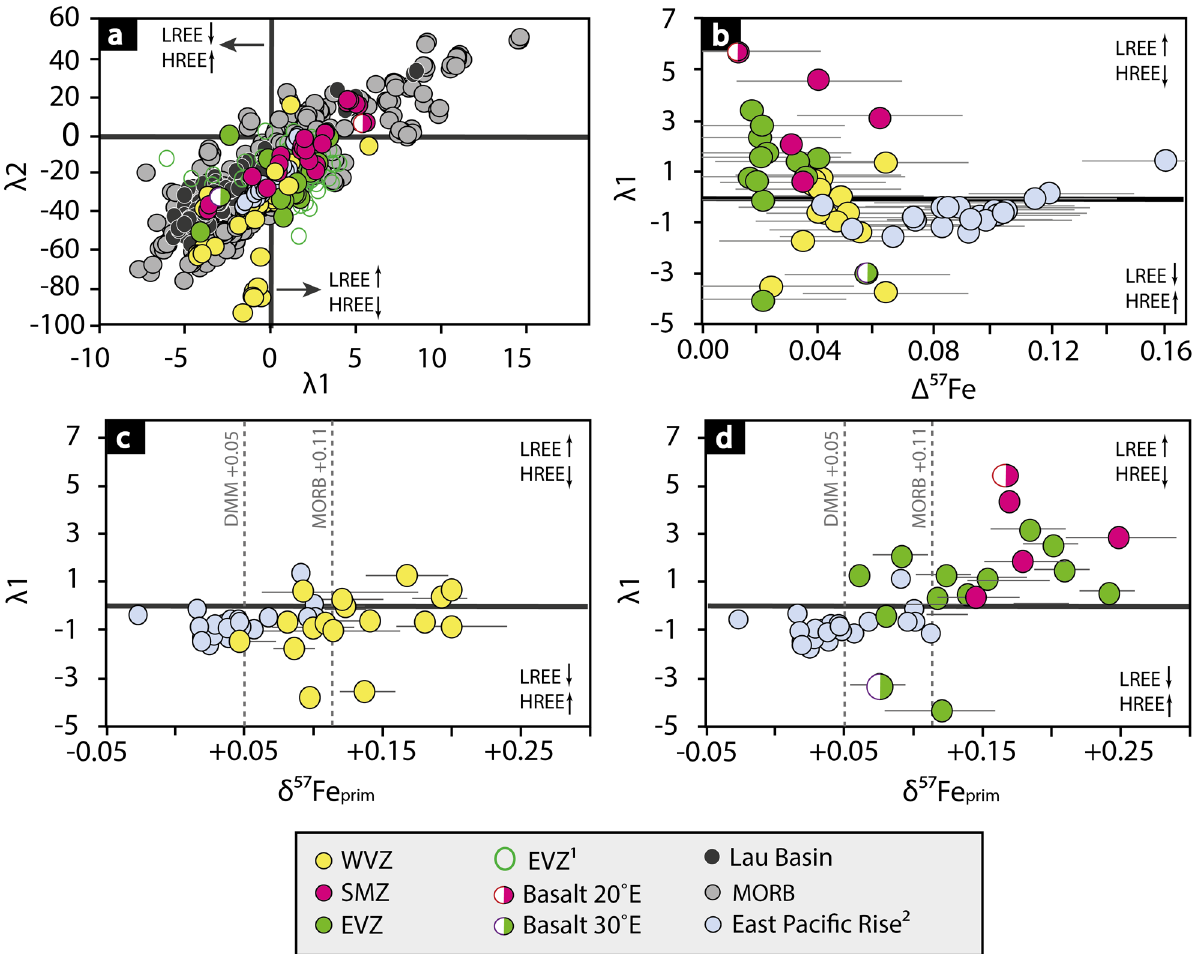
Figure 3. Rare Earth Element (REE) patterns versus δ 57 Fe prim . The REE patterns are given here as λ1 and λ2, describing the slope (λ1) and curvature (λ2) of the REE pattern. These parameter provide further information about the mantle source and petrogenesis 58 , which we link with iron isotope systematics. Lambda variables were calculated using the method of O’Neill 58 . λ1 (slope) can be translated to: λ1 > 0 indicates an enrichment of LREE over HREE, and λ1 < 0 represents the opposite with an enrichment of HREE over LREE. λ2 (curvature) marks the relative difference in LREE over HREE which captures the influence of mineralogy as a function of respective partitioning during fractionation or partial melting. Each basalt sample can have a different curvature for a given λ1 58 . (a) λ2 versus λ1 shows a clear distinction between the basalts from the WVZ and the SMZ, whereas basalts from the EVZ plot in between. MORB data is plotted here for comparison and was calculated from Jenner and O’Neill 57 . ( b ) REE patterns show a negative co-variation with increasing magmatic differentiation Δ 57 Fe. Basalts that experienced a lower degree of fractionation (Δ 57 Fe < 0.04 ‰) display a higher LREE content, compared to basalts that experienced a higher degree of fractionation (Δ 57 Fe > 0.04 ‰). ( c ) and ( d ) show λ1versus δ 57 Feprim for the slow spreading WVZ and the ultraslow spreading SMZ and EVZ. Basalts from the westernmost ridge segment ( c ) display homogenous REE pattern, which co-align with the data from the super-fast East Pacific Rise data 49 . In contrast, the SMZ and the EVZ lavas ( d ) from the ultraslow spreading ridge display a higher enrichment in LREE (λ1 > 0) compared to the WVZ and East Pacific Rise lavas from faster spreading regimes 49 . The two grey vertical dashed lines represent the iron isotope value of the depleted MORB mantle (DMM) 59 and MORB 25,49 . 1—literature data for EVZ basalts are compiled from Gale et al. 2 . 2—literature data from the East Pacific Rise basalts are taken from Chen et al. 49 isotope variations, due to enhanced fractional crystallisation resulting in a higher iron isotopic fractionation and thus a higher calculated Δ 57 Fe. In analogy, the same systematic would apply to other MORBs. Basalts from the WVZ indicate a slightly stronger control of crystal fractionation (Δ 57 Fe > 0.04 ‰; lower Mg# 55–62) compared to basalts from the EVZ and the SMZ (Δ 57 Fe < 0.04 ‰; higher Mg# 57–67). This slight differ- ence is consistent with the small variation in spreading rate (Fig. 6). We suggest that melts at the WVZ travel through a mid-crustal magma lens or magma reservoir (Fig. 7 profile A) in which the melt experienced crystal fractionation. In contrast, samples from the SMZ and the EVZ are from an amagmatic area of low magmatic activity with a thin oceanic crust 1,50,63,66 . All listed characteristics in the SMZ and the EVZ are typical for ultraslow spreading rates 1,3,10,50 . The low magmatic activity, in particular in the EVZ, may stem from potentially colder